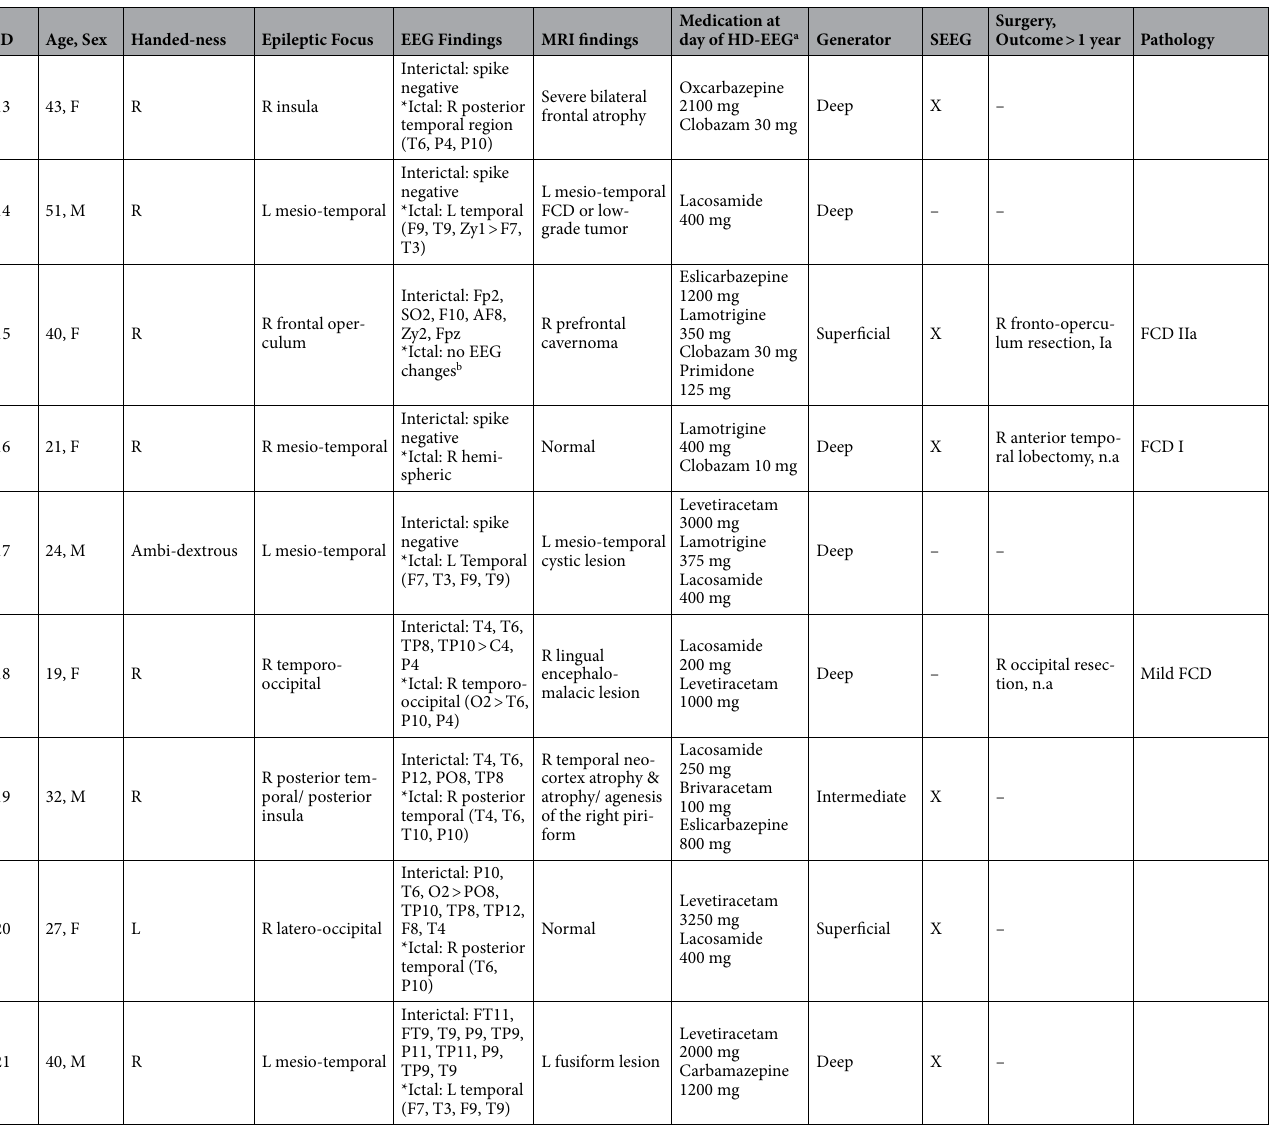
Table 1. Patient demographics. F female, M male, R right, L left, MTS mesial temporal sclerosis, FCD focal cortical dysplasia, RFTC radiofrequency thermocoagulation, n.a. not applicable (follow up duration < 1